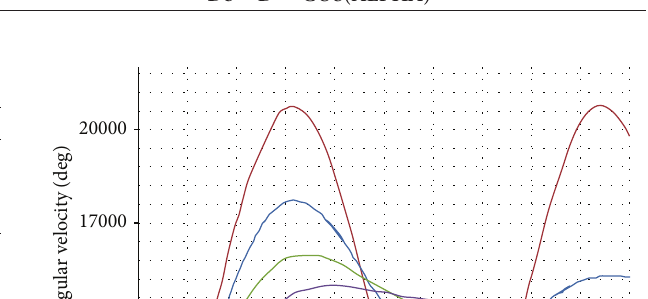
Table 4: Values of 𝐽 󸀠 𝑠𝑧𝑒2 , 𝐽 󸀠 𝑐𝑑𝑒2 , and 𝐽 󸀠 𝑧𝑐𝑒2 .